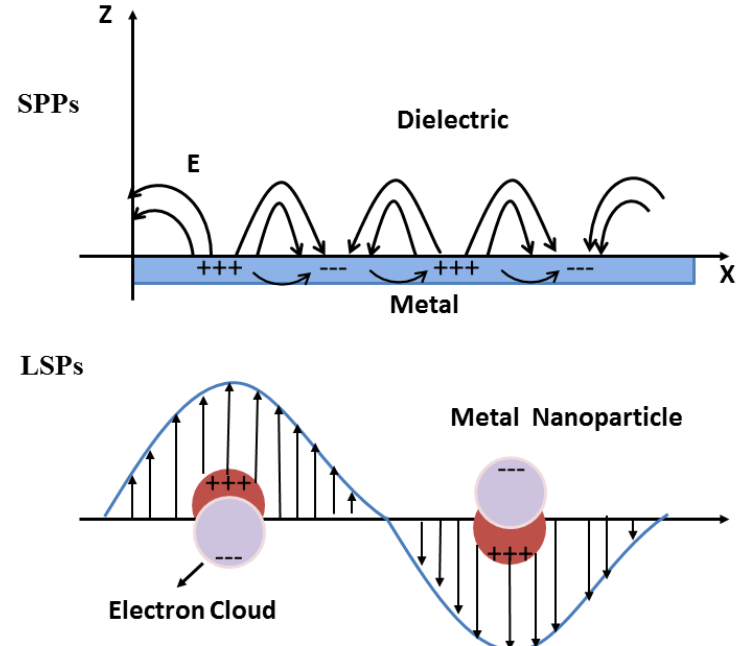
Figure 2. Two types of nanostructure. Adapted from Ref. [35].